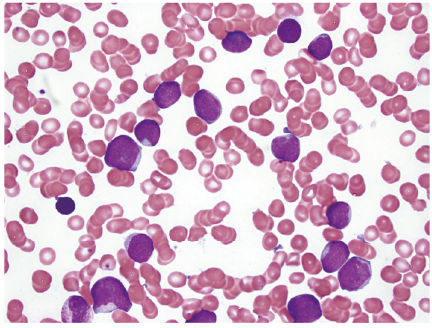
Figure 5: Bone marrow aspirate smear from patient #2, Wright-Giemsa,